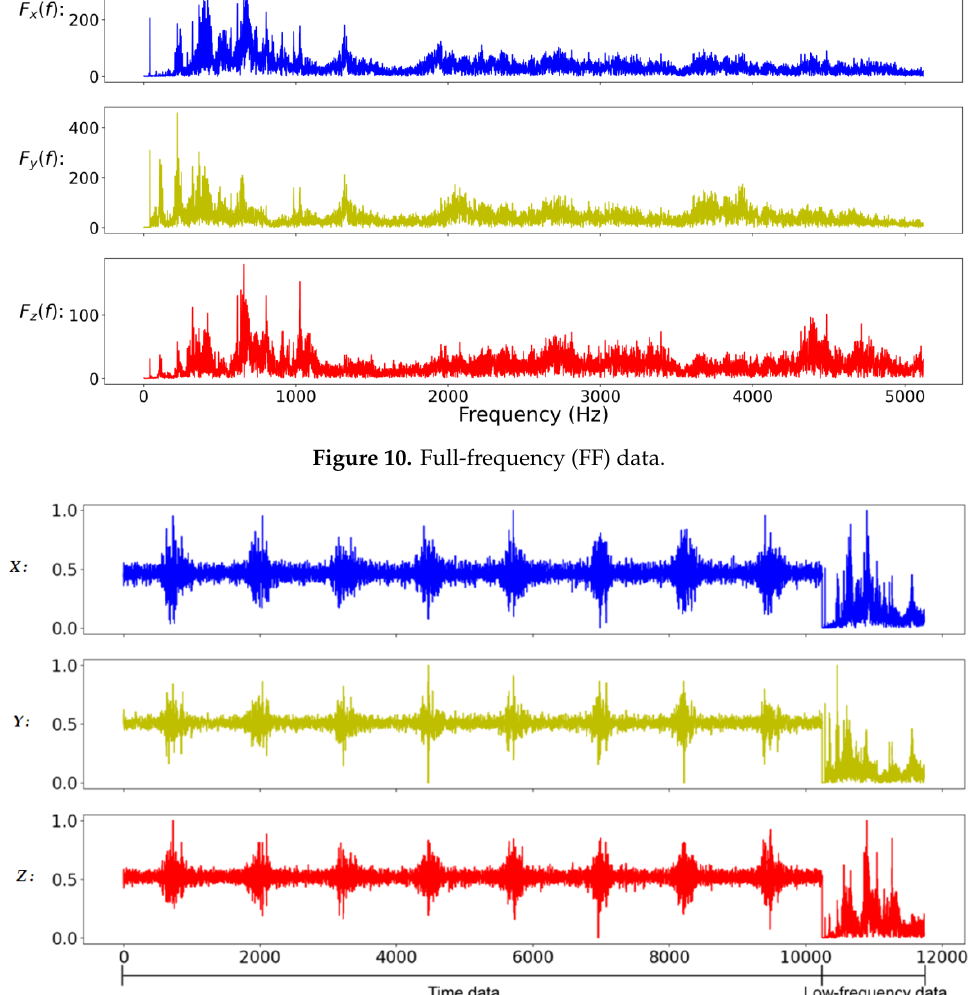
Figure 11. Full-time combining low-frequency (FTCLF) data with normalization.